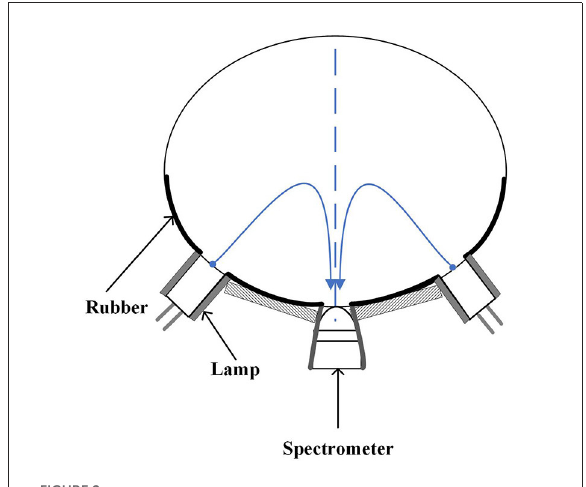
FIGURE2 Optical geometry of H100F